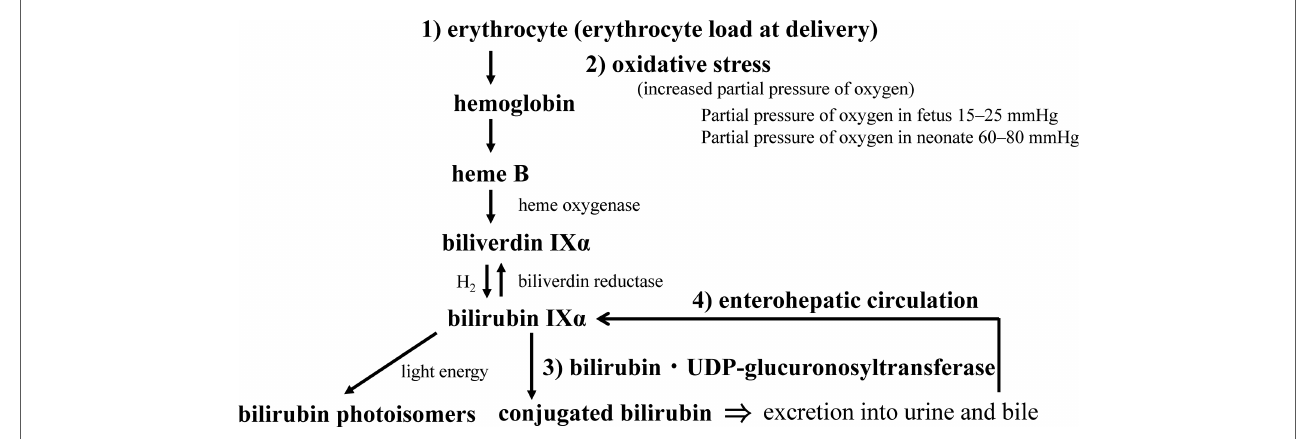
FIGURE 4 Neonatal bilirubin metabolism. The perinatal metabolism of bilirubin is summarized in terms of (1) bilirubin load, (2) its response to oxidative stress at birth, (3) the development of conjugating enzymes, and (4) the signi fi cance of the enterohepatic circulation (see text for